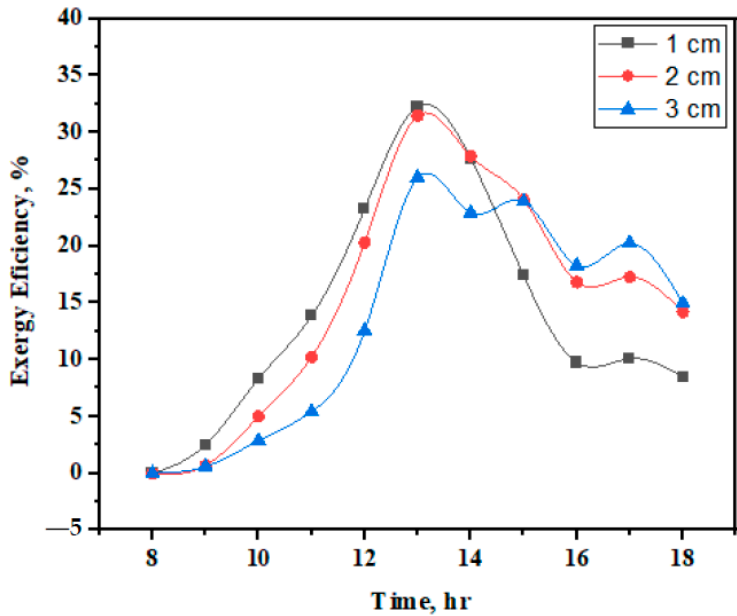
Figure 11. Exergy efficiency with respect to time.